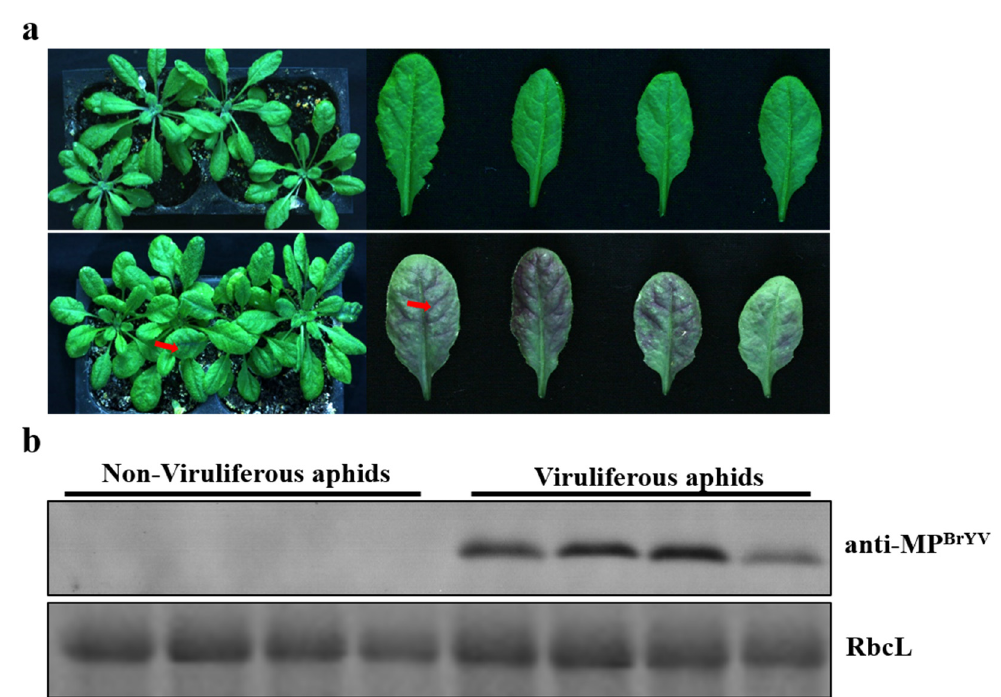
Table 4. Minimal inoculation times for viral transmission by six aphids.